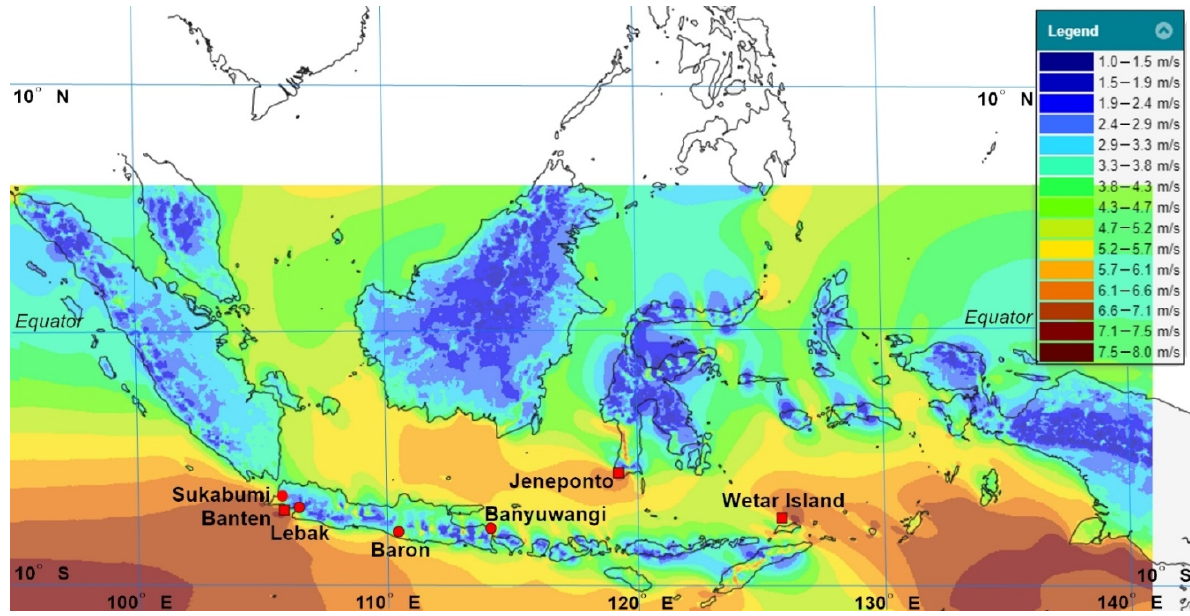
Figure 1. WRF map of Indonesia generated using the ERA-Interim data map (2004–2015) [20]. The locations of onshore sites in Banyuwangi, Baron, Lebak, and Sukabumi (circular points) and offshore sites in Jeneponto, Wetar Island, and Banten (square points) are indicated. The colored contours denote horizontal wind speeds at a height of 100 m.